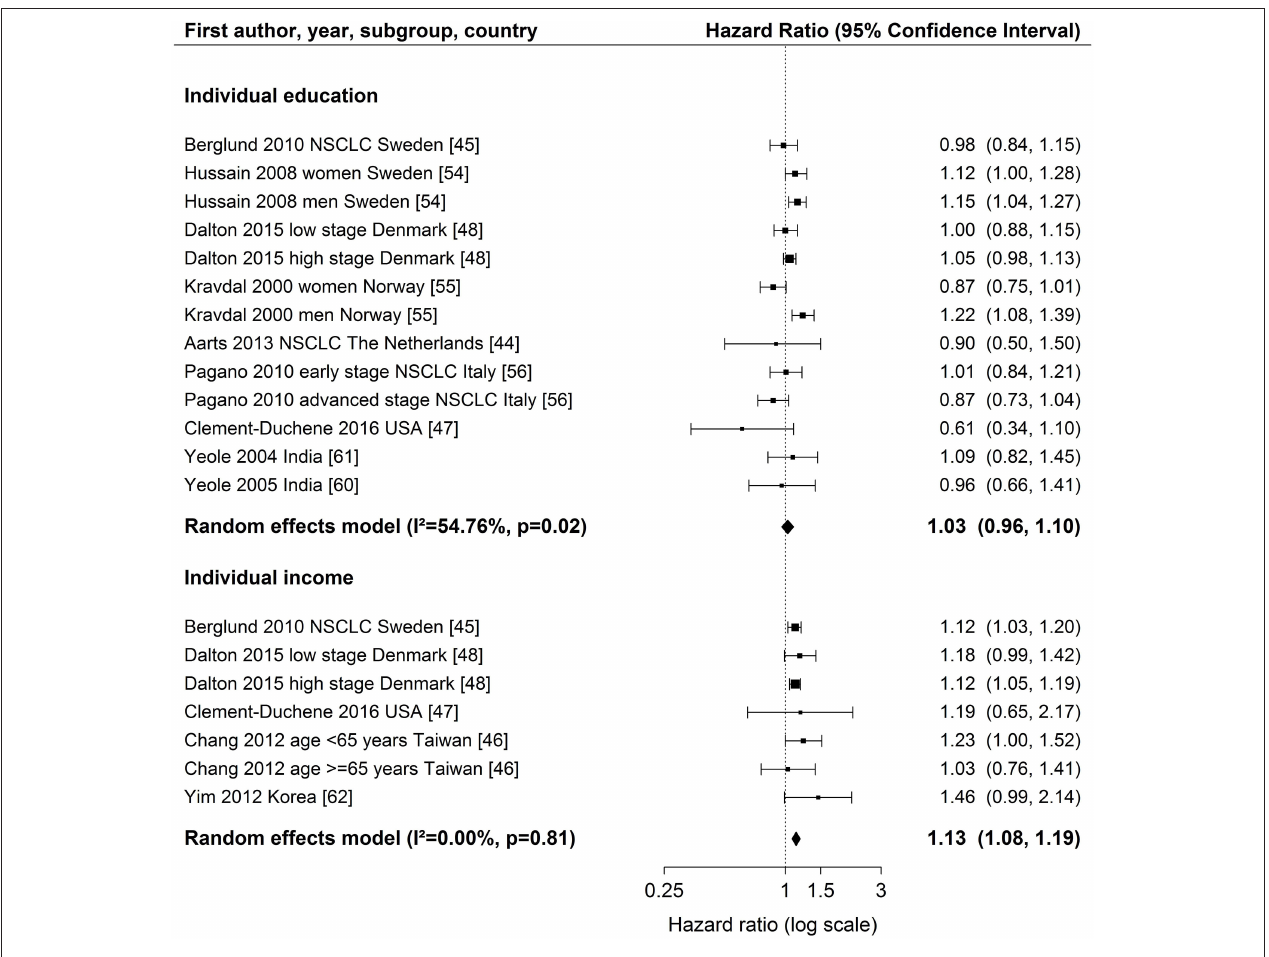
FIGURE 2 | Meta-analyses of studies on the association of individual education / income (reference: high income/education) and survival after lung cancer. NSCLC, non-small cell lung cancer. Kravdal ( 55): highest educational group, men = 17 + years, women = 13–17 + years. Chang et al. (46): high income category = high individual AND high neighborhood income (reference), low income category = low individual AND low neighborhood